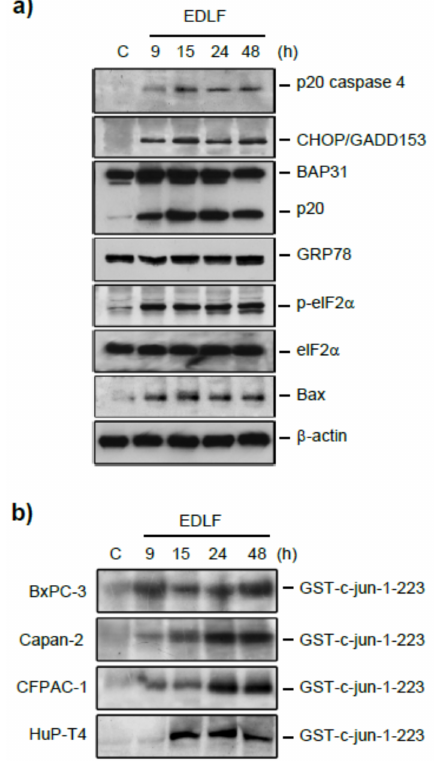
Figure 9. Edelfosine induces ER stress in human pancreatic cancer cells. ( a ) HuP-T4 cells, untreated (C) or treated with 20 µ M edelfosine (EDLF) for the indicated times, were analyzed via Western blot using specific antibodies for the indicated proteins and ER stress markers; β -actin was used as a loading control. ( b ) The indicated pancreatic cancer cells, untreated (C) or treated with 20 µ M edelfosine (EDLF) for the indicated times, were analyzed for JNK activation, as assessed by a solid- phase JNK assay using GST-c-Jun-1-123 as a substrate. See text for details. Images taken from